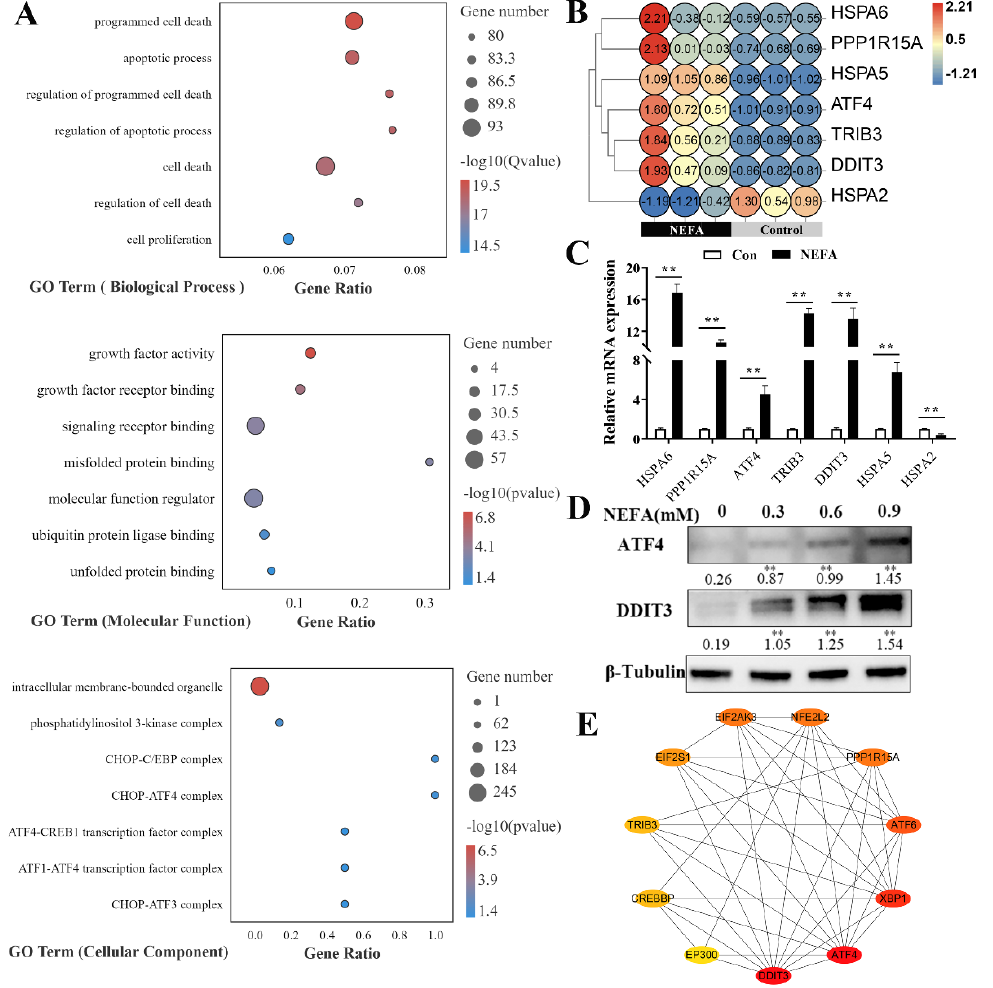
Figure 4. GO enrichment analysis and verification of the different NEFA treatment − activated genes. ( A ) Bubble plot of GO enrichment analysis. ( B ) Thermogram analysis of expressions (log10(FPKM+1)) of 7 target genes. ( C ) qPCR verification of expression modes of 7 target genes. ( D ) Protein expression of ATF4 and CHOP(DDIT3) in BMECs stimulated with NEFA for 6 h. ( E ) Protein and protein interaction network of CHOP(DDIT3) and ATF4. Data are presented as the means ± the standard errors of the mean (SEM) of three independent experiments. ** p <